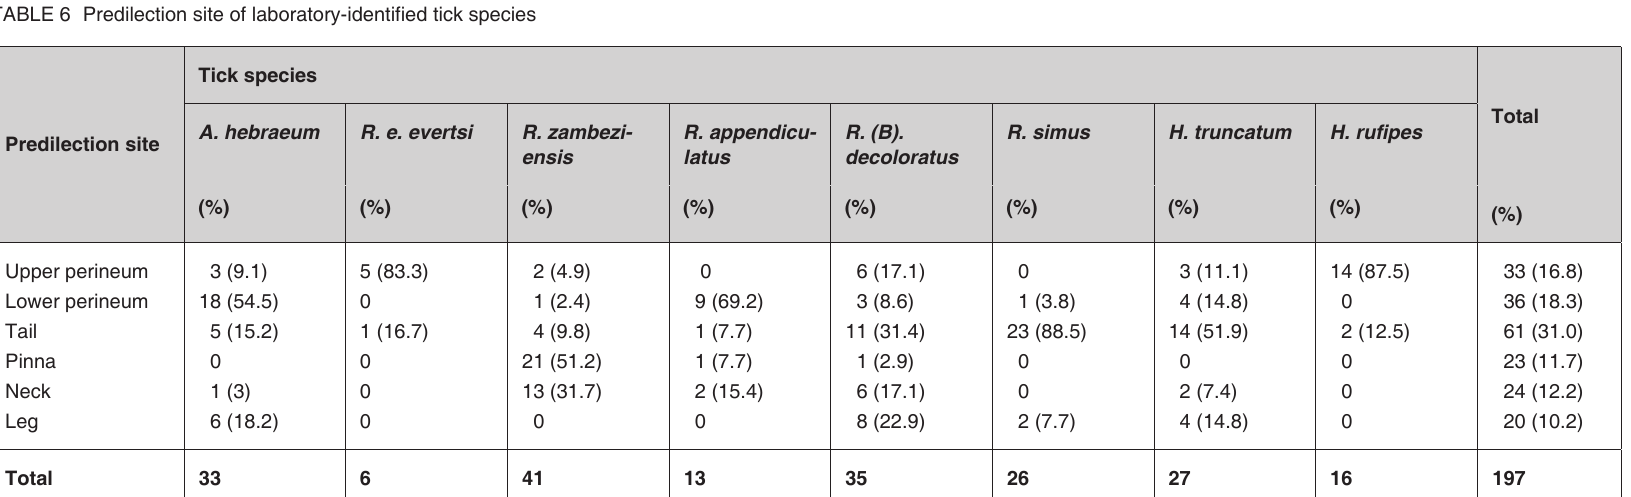
TABLE 6 Predilection site of laboratory-identified tick